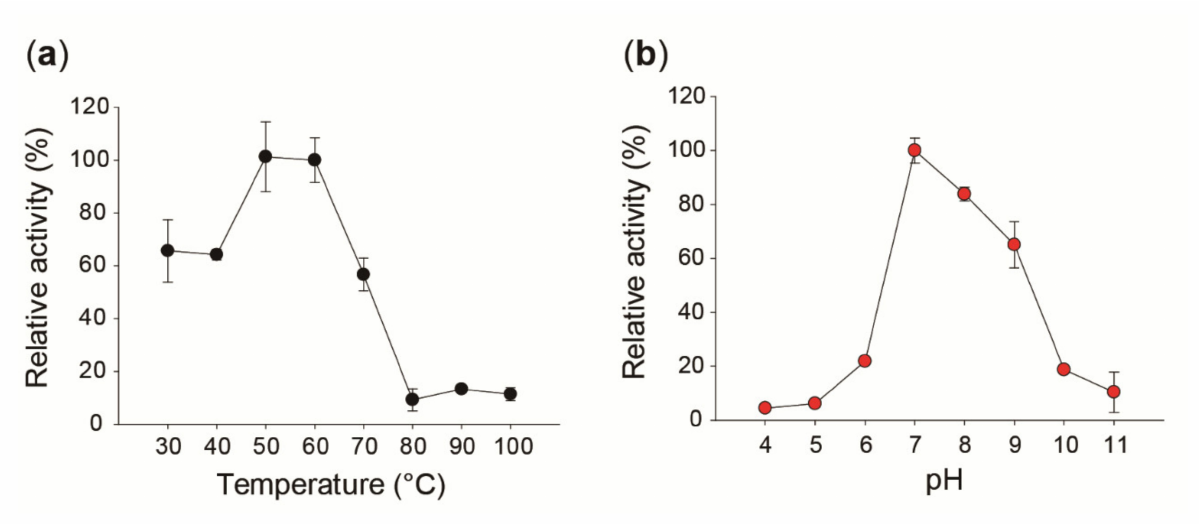
Figure 4. ( a ) Effect of temperature on the L -fuculose-isomerizing activity of Ho FucI. Enzyme reactions were performed at various temperatures ranging from 30 to 100 ◦ C with 7 µ g of Ho FucI and 10 mM L -fuculose for 5 min in 20 mM sodium phosphate (pH 7.0) buffer in the presence of 1 mM Mn 2+ and 0.5 M NaCl. The experimental data represent the means ± standard deviations. Relative activity (%) represents the enzyme activity relative to that obtained at 60 ◦ C, set as 100%. ( b ) Effect of pH on the L -fuculose-isomerizing activity of Ho FucI. Enzyme reactions were performed at various pH ranging from 4 to 11 with 7 µ g of Ho FucI and 10 mM L -fuculose at 60 ◦ C for 5 min in the presence of 1 mM Mn 2+ and 0.5 M NaCl. The buffers used were 100 mM sodium acetate (pH 4, 5, and 6), 100 mM sodium phosphate (pH 7 and 8), and 100 mM glycine-NaOH (pH 9, 10, and 11). The experimental data represent the means ± standard deviations. Relative activity (%) represents the enzyme activity relative to that obtained at pH 7, set as 100%.